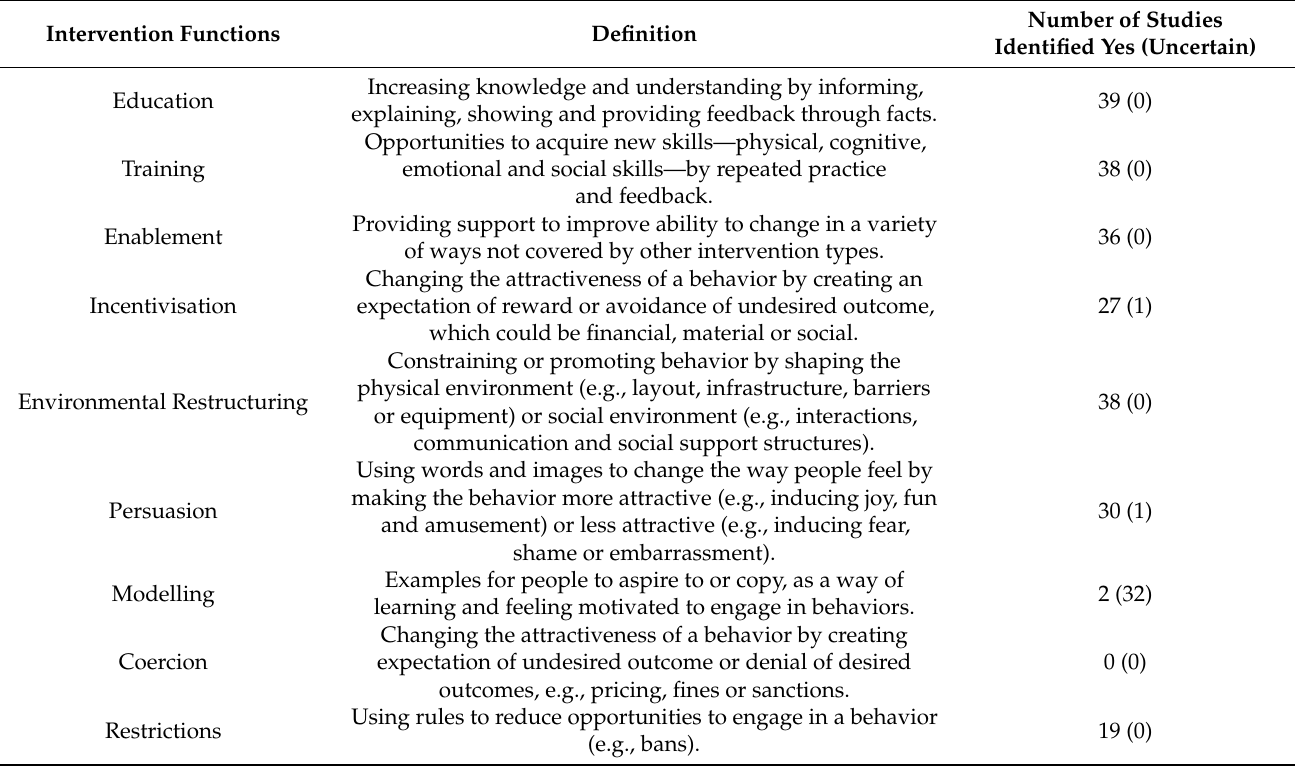
Table 2. Number of Studies, Including Intervention Functions and Policy Categories